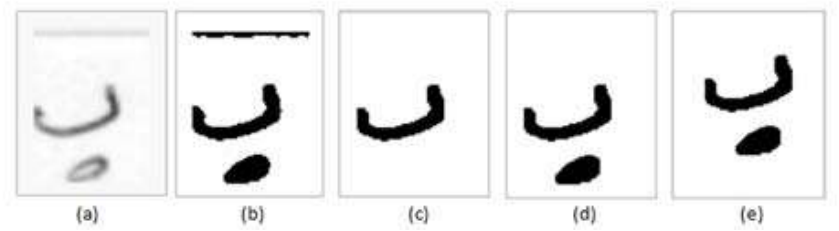
Figure 1. Preprocess stages. a)Main image. b) Binerized image. c) Biggest object of character. d)After applying morphology filter on b. e)Centralized action on